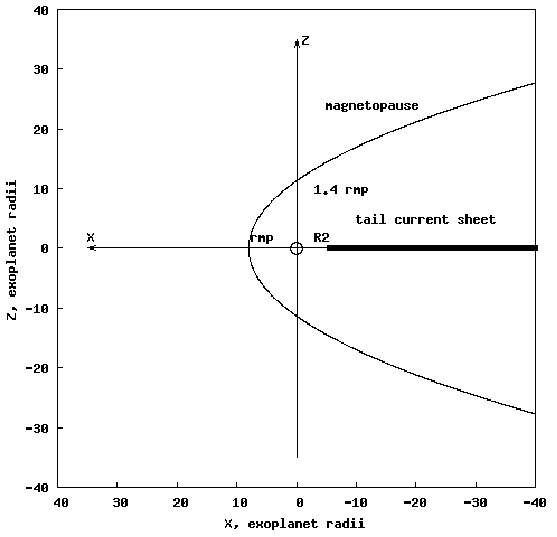
Figure 1. The scheme illustrates used parameters in the paraboloid